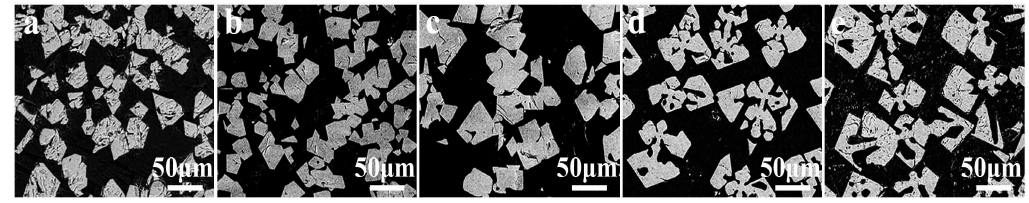
Figure 6. SEM images of cooled samples after treatment at different holding temperatures. ( a ) 1623 K; ( b ) 1673 K; ( c ) 1723 K; ( d ) 1773 K; ( e ) 1823 K.